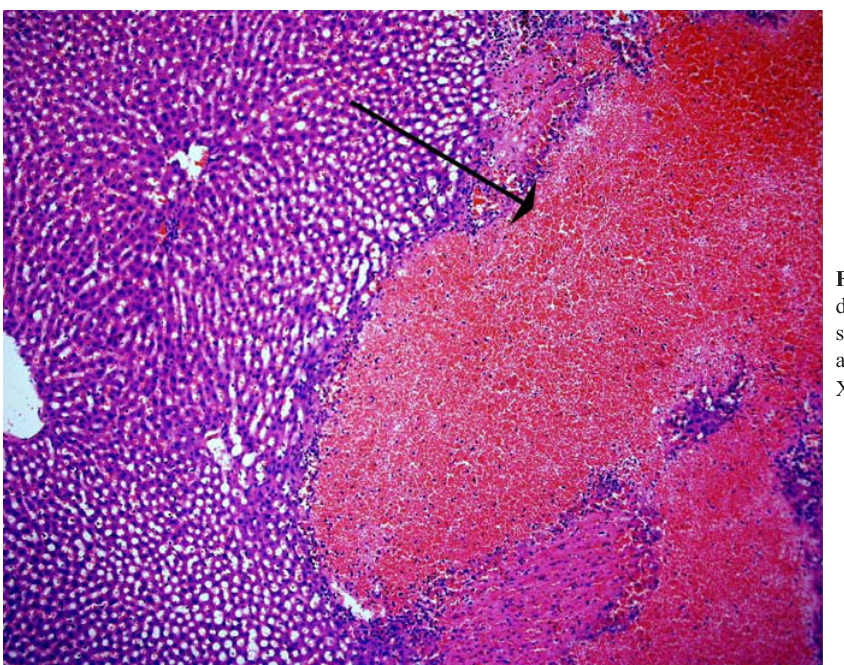
de coelho decorridas 24 horas da injeção de solução salina. Área de hemorragia (seta) adjacente ao parênquima hepático normal.